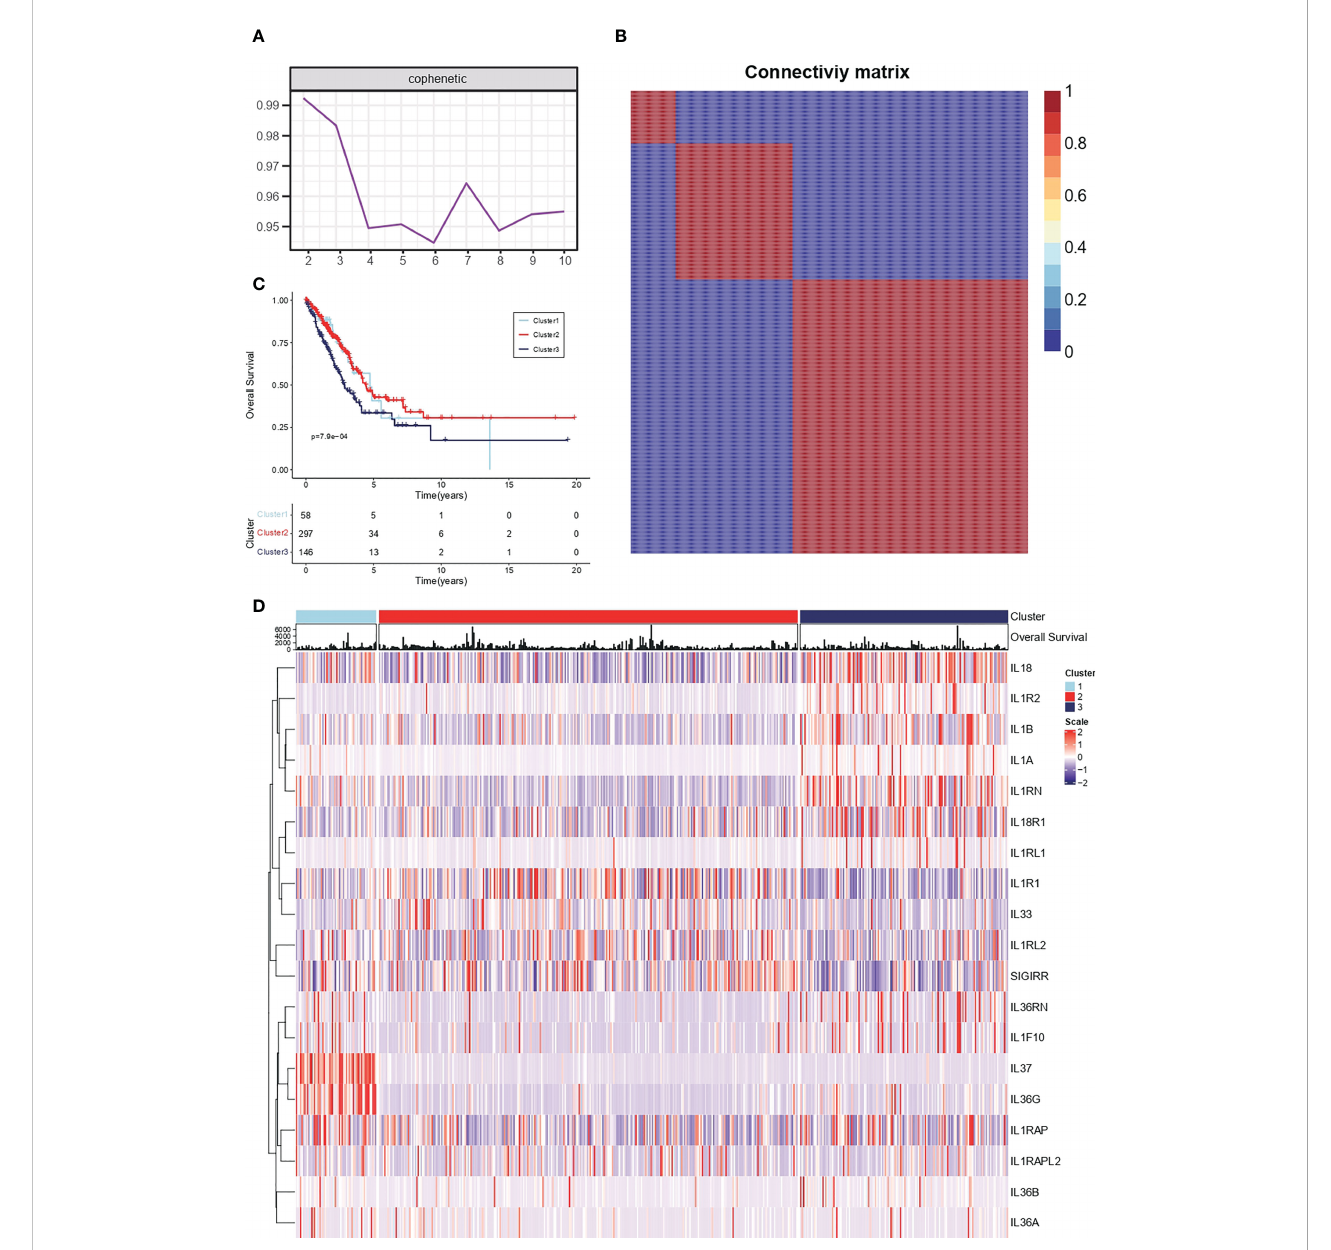
FIGURE 1 Conserved molecular typing of IL-1 signalling in lung adenocarcinoma. (A) Factorization rank for 2-10 clusters. (B) Heatmap of the gene expression of three clusters. (C) K-M curves of different IL-1 subtypes of lung adenocarcinoma. (D) Molecular characteristics of IL-1 among different clusters of TCGA-